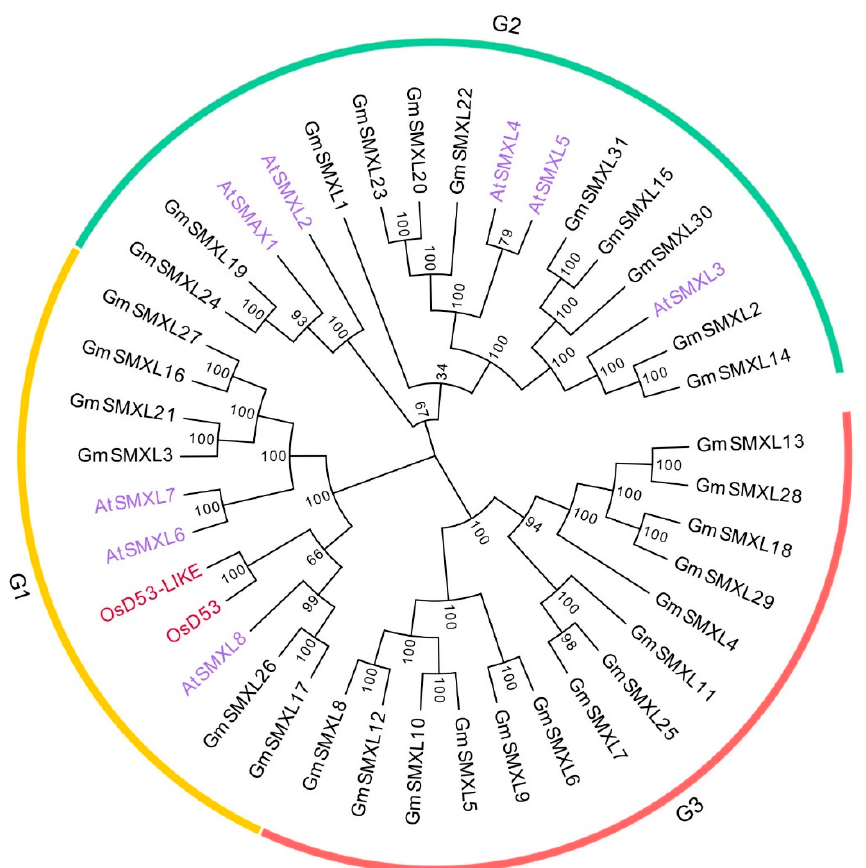
Figure 1. Phylogenetic tree of SMXL proteins from Glycine max , Arabidopsis thaliana and Oryza sativa. The SMXL protein sequences of the three species were aligned by the ClustalW method implemented in the MEGA version7, and the tree was built with the neighbor-joining (NJ) method. Gm represents Glycine max ; At represents Arabidopsis thaliana ; Os represents Oryza sativa , respectively.